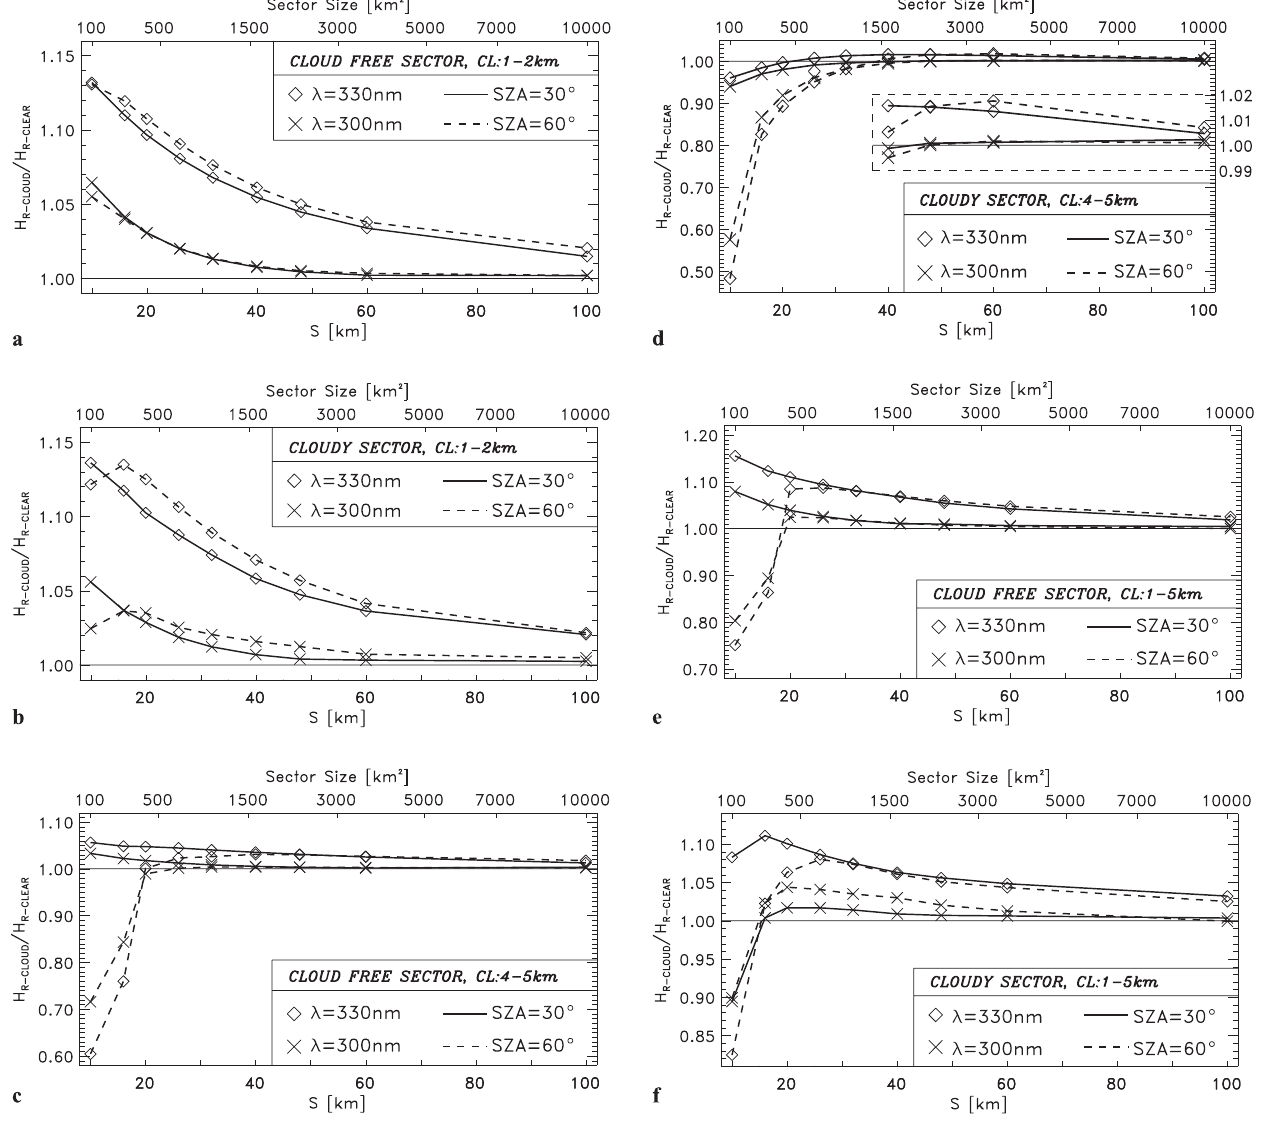
embedded within layer CL (Fig. 2). Results are presented for a , b CL = 1–2 km, c , d CL = 4–5 km and e , f CL=1–5 km. The mean distance between the observer at sector center and the nearest remote clouds is 0 : 56 (cid:1) S . The inset in Fig. 3d shows the ratio H R (cid:255) Cloud = H R (cid:255) Clear for S (cid:21) 40 km on a